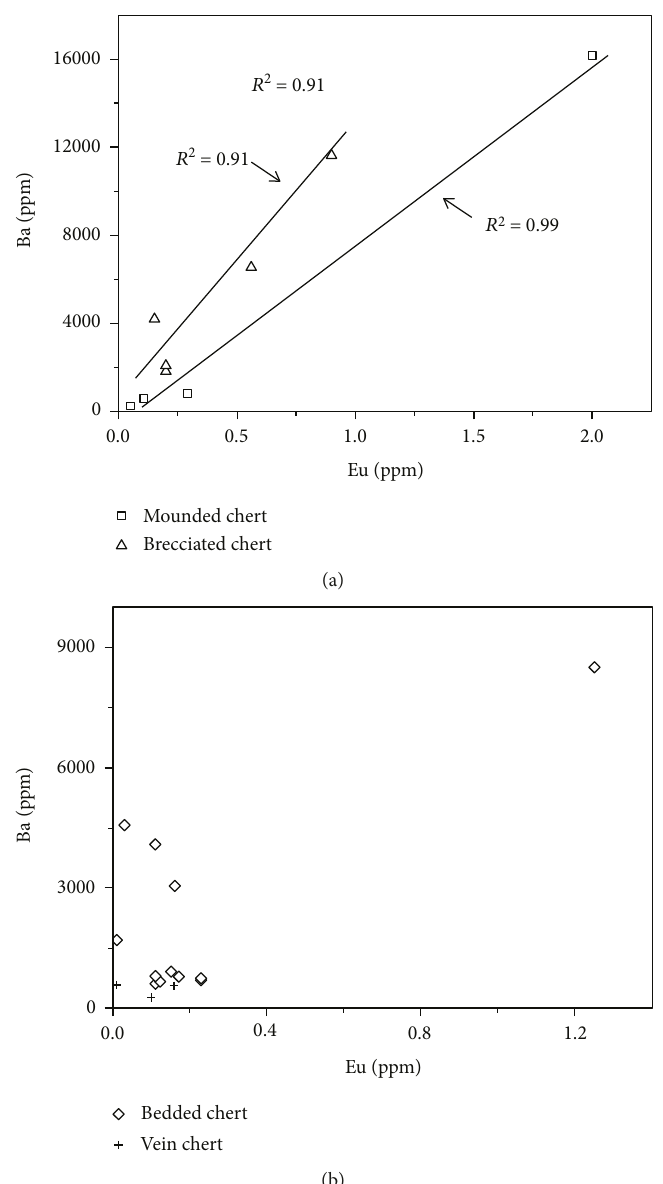
Figure 8: Correlations of Ba and Eu contents in (a) mounded and brecciated chert and (b) vein and bedded chert in the work of Wang et al. [25]. Linear correlations with R 2 of 0.99 and 0.91 are observed in mounded and brecciated chert,